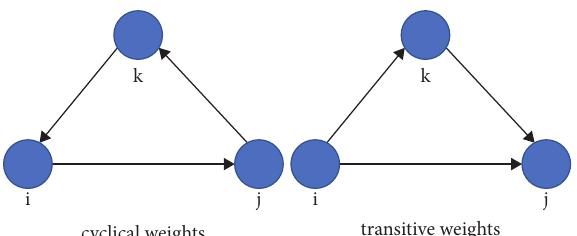
Figure 7: An illustration of cyclical weights and transitive weights. It refers to three-way competition in the market: (a) cyclical weights and (b) transitive